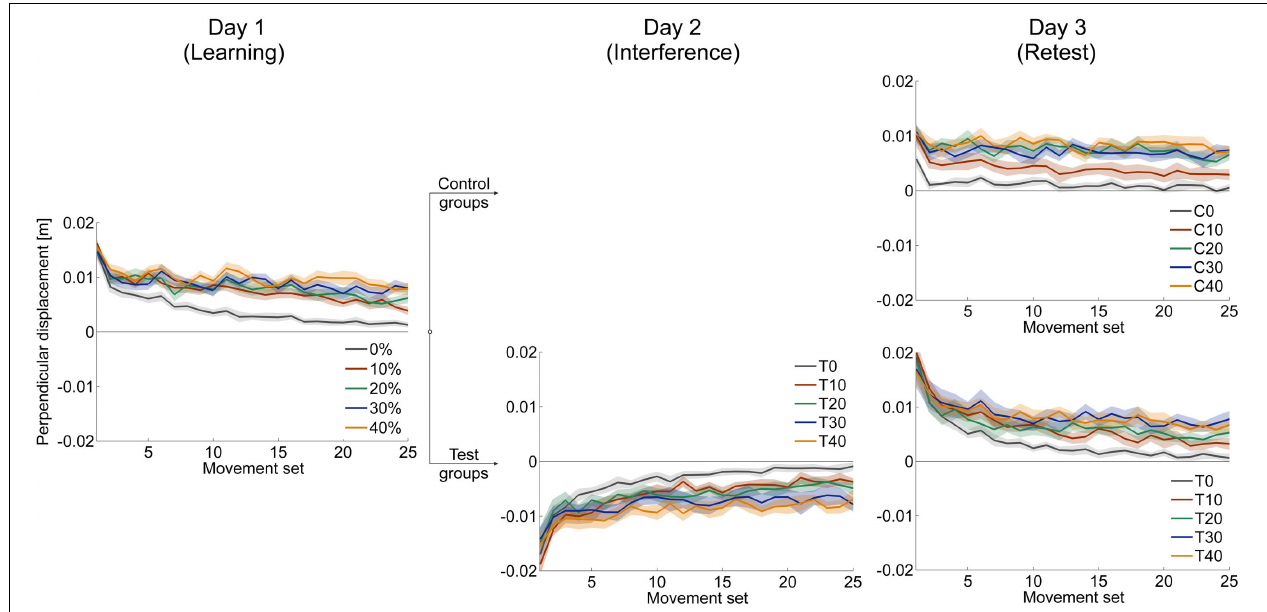
FIGURE 4 | Mean time courses of signed perpendicular displacement 300ms after movement start in force field trials. Positive (negative) values indicate deviations in clockwise (counterclockwise) direction caused by